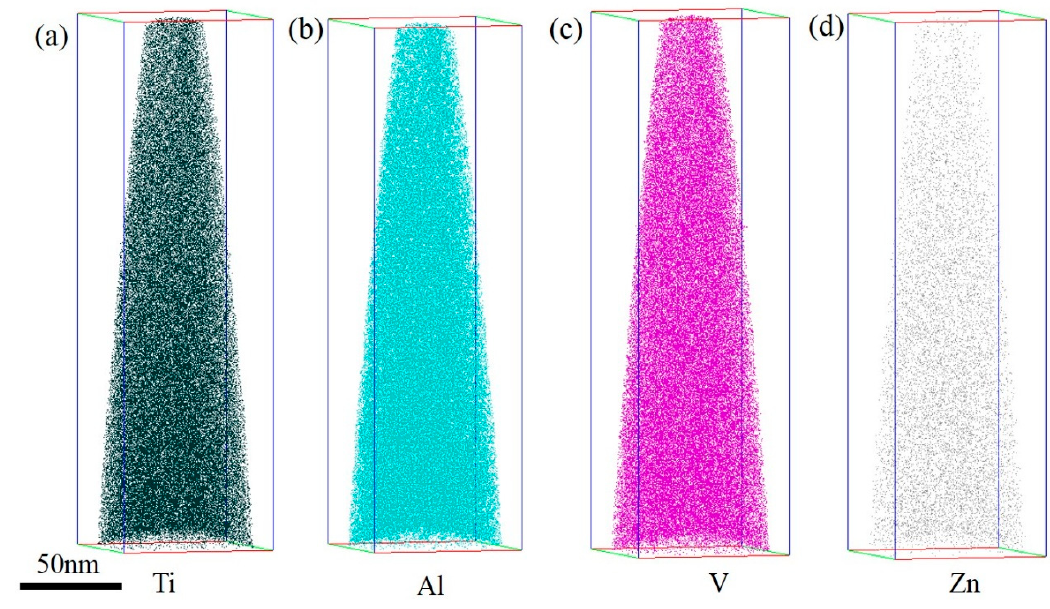
Figure 7. 3DAP atoms mapping results of TC4 / Zn composite: ( a ) Ti, ( b ) Al, ( c ) V and ( d )